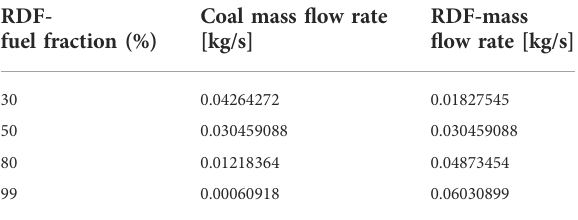
TABLE 8 Fuel mass fl ows as a function of the RDF fuel. RDF- fuel fraction